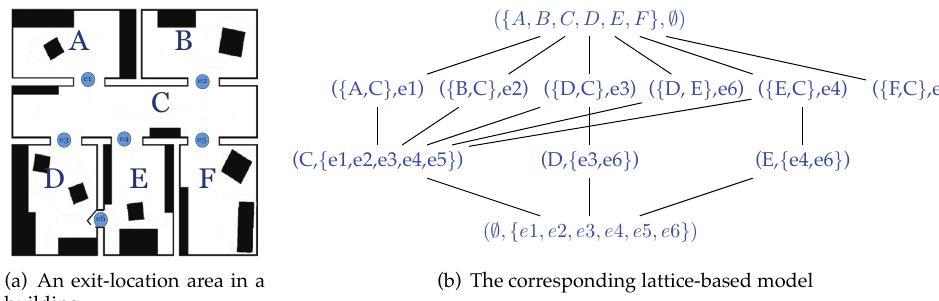
Figure 7: Example of a place-based set